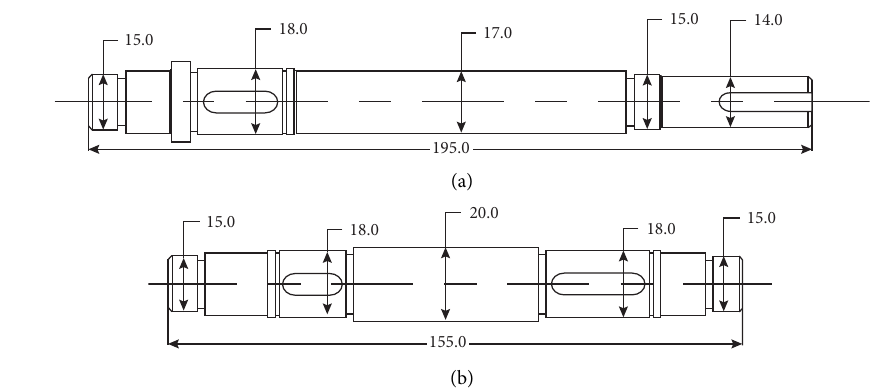
Figure 1: Dimension drawing of the shaft.